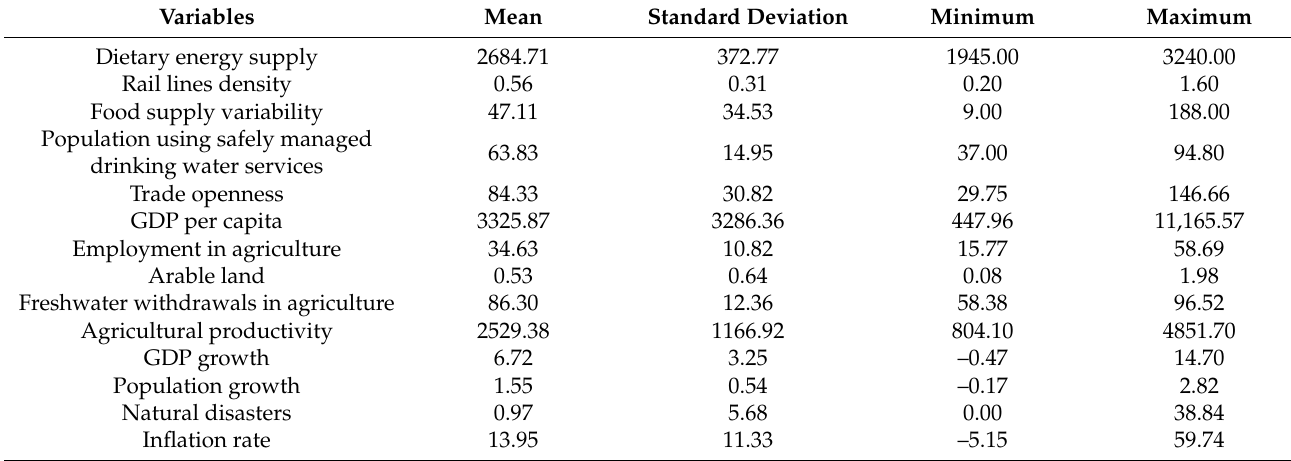
Table 2. Variables’ descriptive statistics.